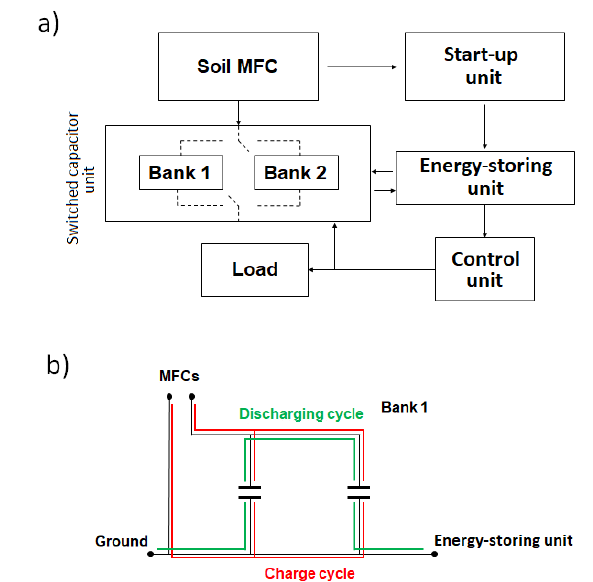
Figure 3. ( a ) System bloc diagram; and ( b ) capacitor bank